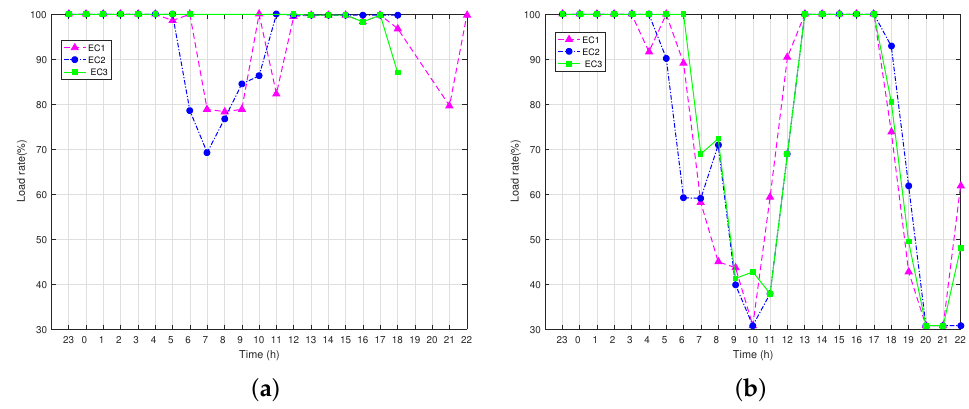
Figure 9. The operation load rate of all ECs in different mode. ( a ) Case 1 ; ( b ) Case 2